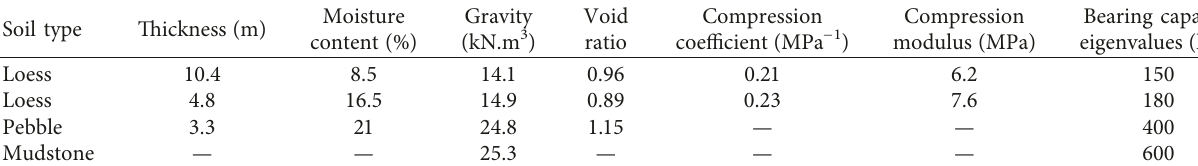
Table 1: Physical and mechanical parameters of subsoil.